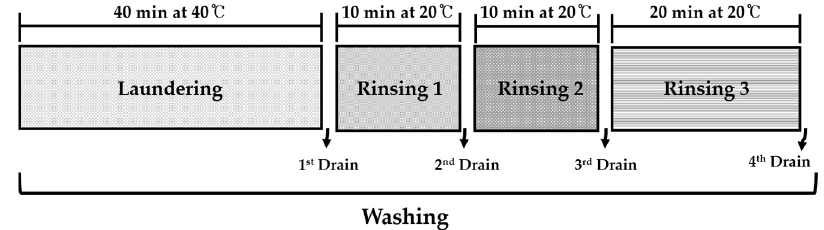
Figure 2. Washing procedures of a standard washing course.